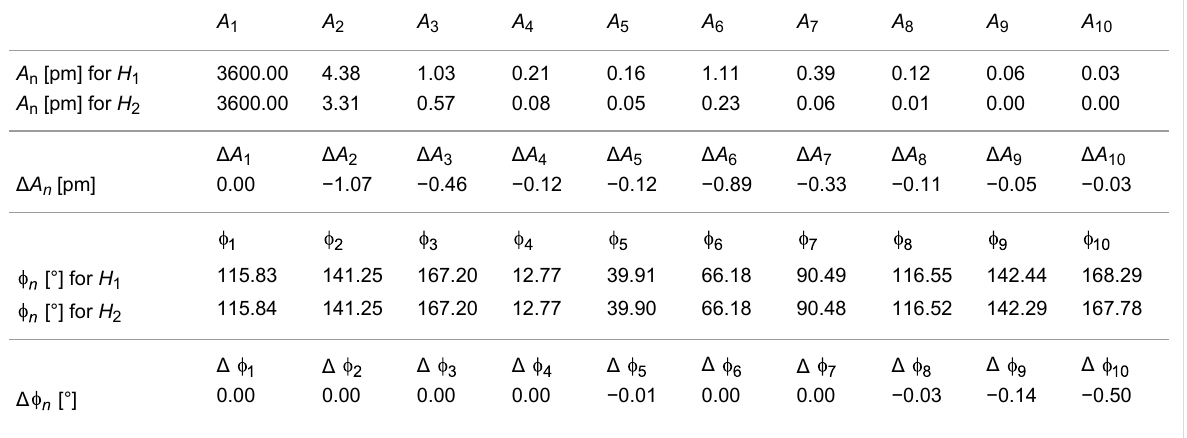
Table 1: Harmonic amplitudes A n and the corresponding phase shifts that result from Hamaker values of H 1 = 0.2 × 10 − 19 J and H 2 = 1.4 × 10 − 19 J. The differences in amplitudes Δ A n and phases Δ are also shown. A single external drive force has been employed (the funda- mental frequency) and no thermal noise has been allowed.